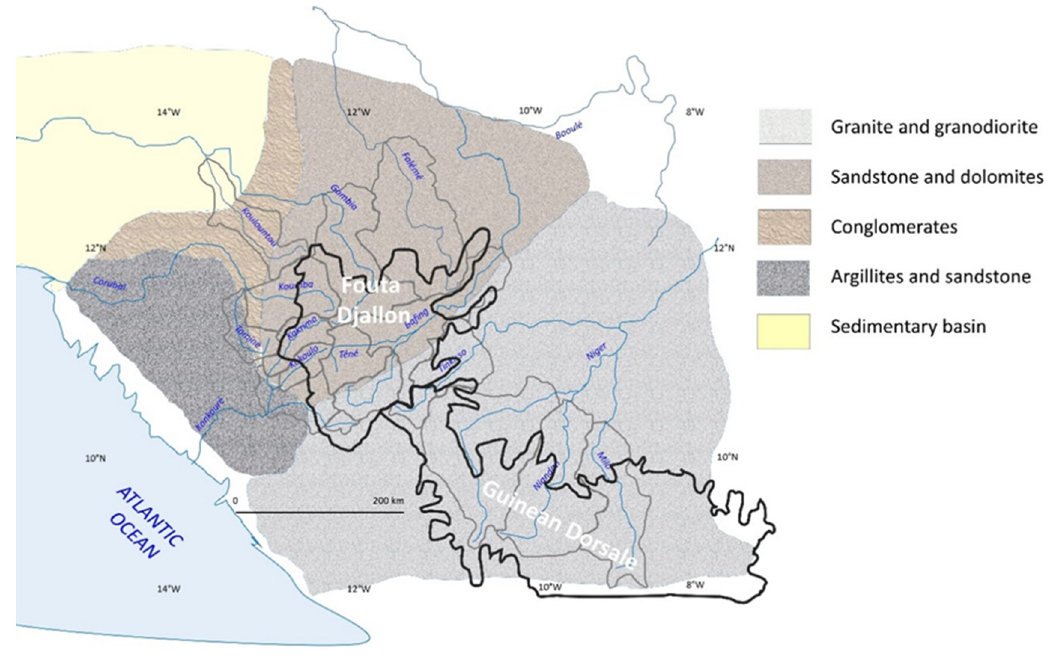
Figure 2. The main geological parts of the Fouta Djallon and Guinean Dorsale ensemble.